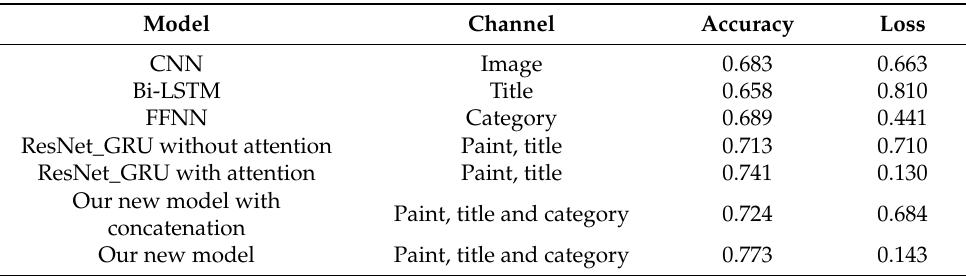
Table 3. Performance on test set in terms of the accuracy on the three